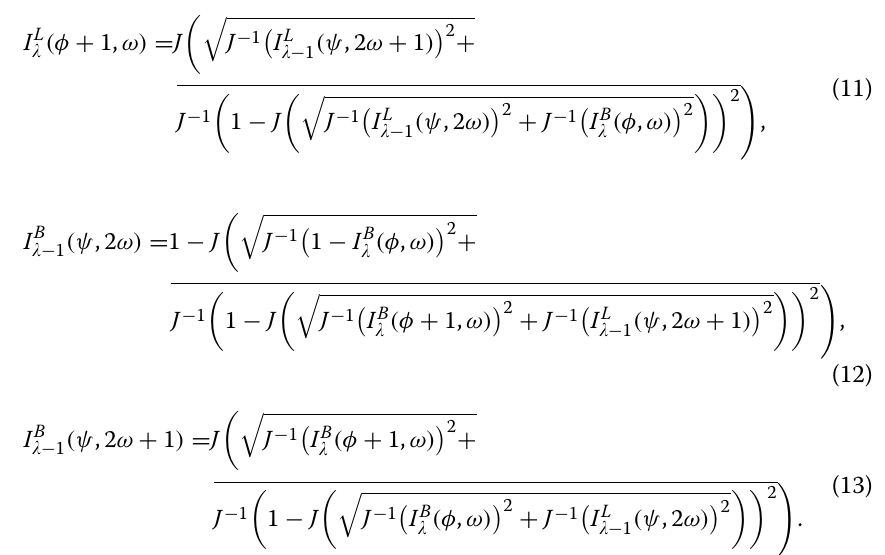
L (cid:31) 1 , in lines 5 and 6 of +